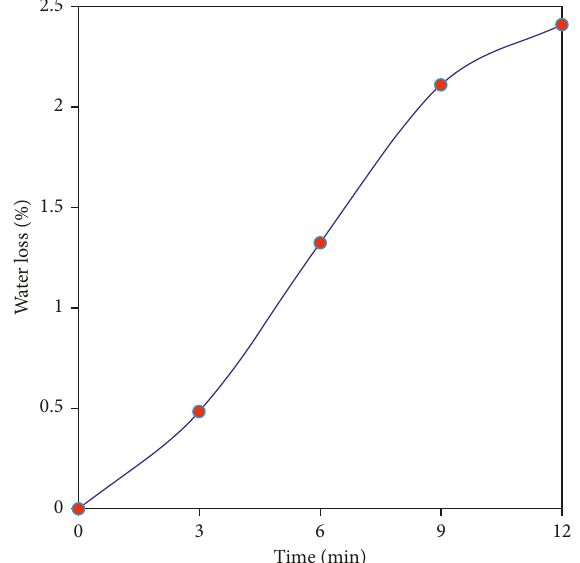
Figure 4: Water loss from PANI/PVC-PEDOT: PSS-ZrP membrane.